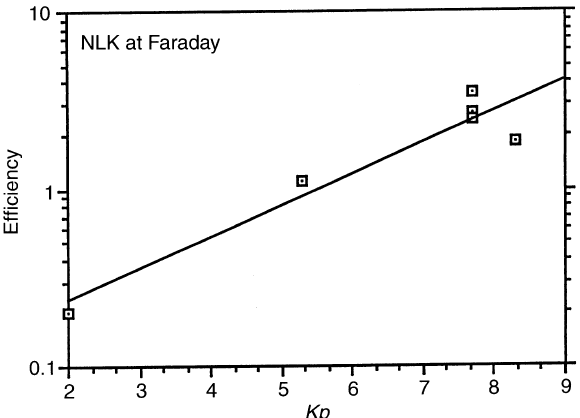
Fig. 2. A plot of the e(cid:129)ciency of ducts determined from whistler- mode signals from NLK received at Faraday versus the maximum K p in the preceeding 2 days